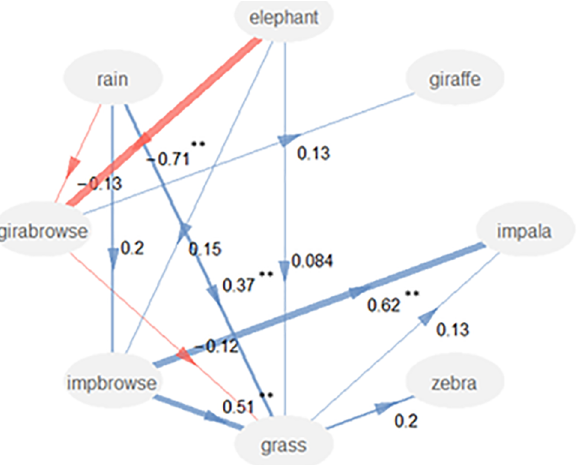
Fig 3. Results of the path model for three areas pooled together. Circles are latent variables and arrows illustrate interactions. Numbers are regression coefficients. (cid:3) = P < 0.05, (cid:3)(cid:3) = p < 0.01. Girabrowse is browse availability for giraffes and impbrowse is browse availability for